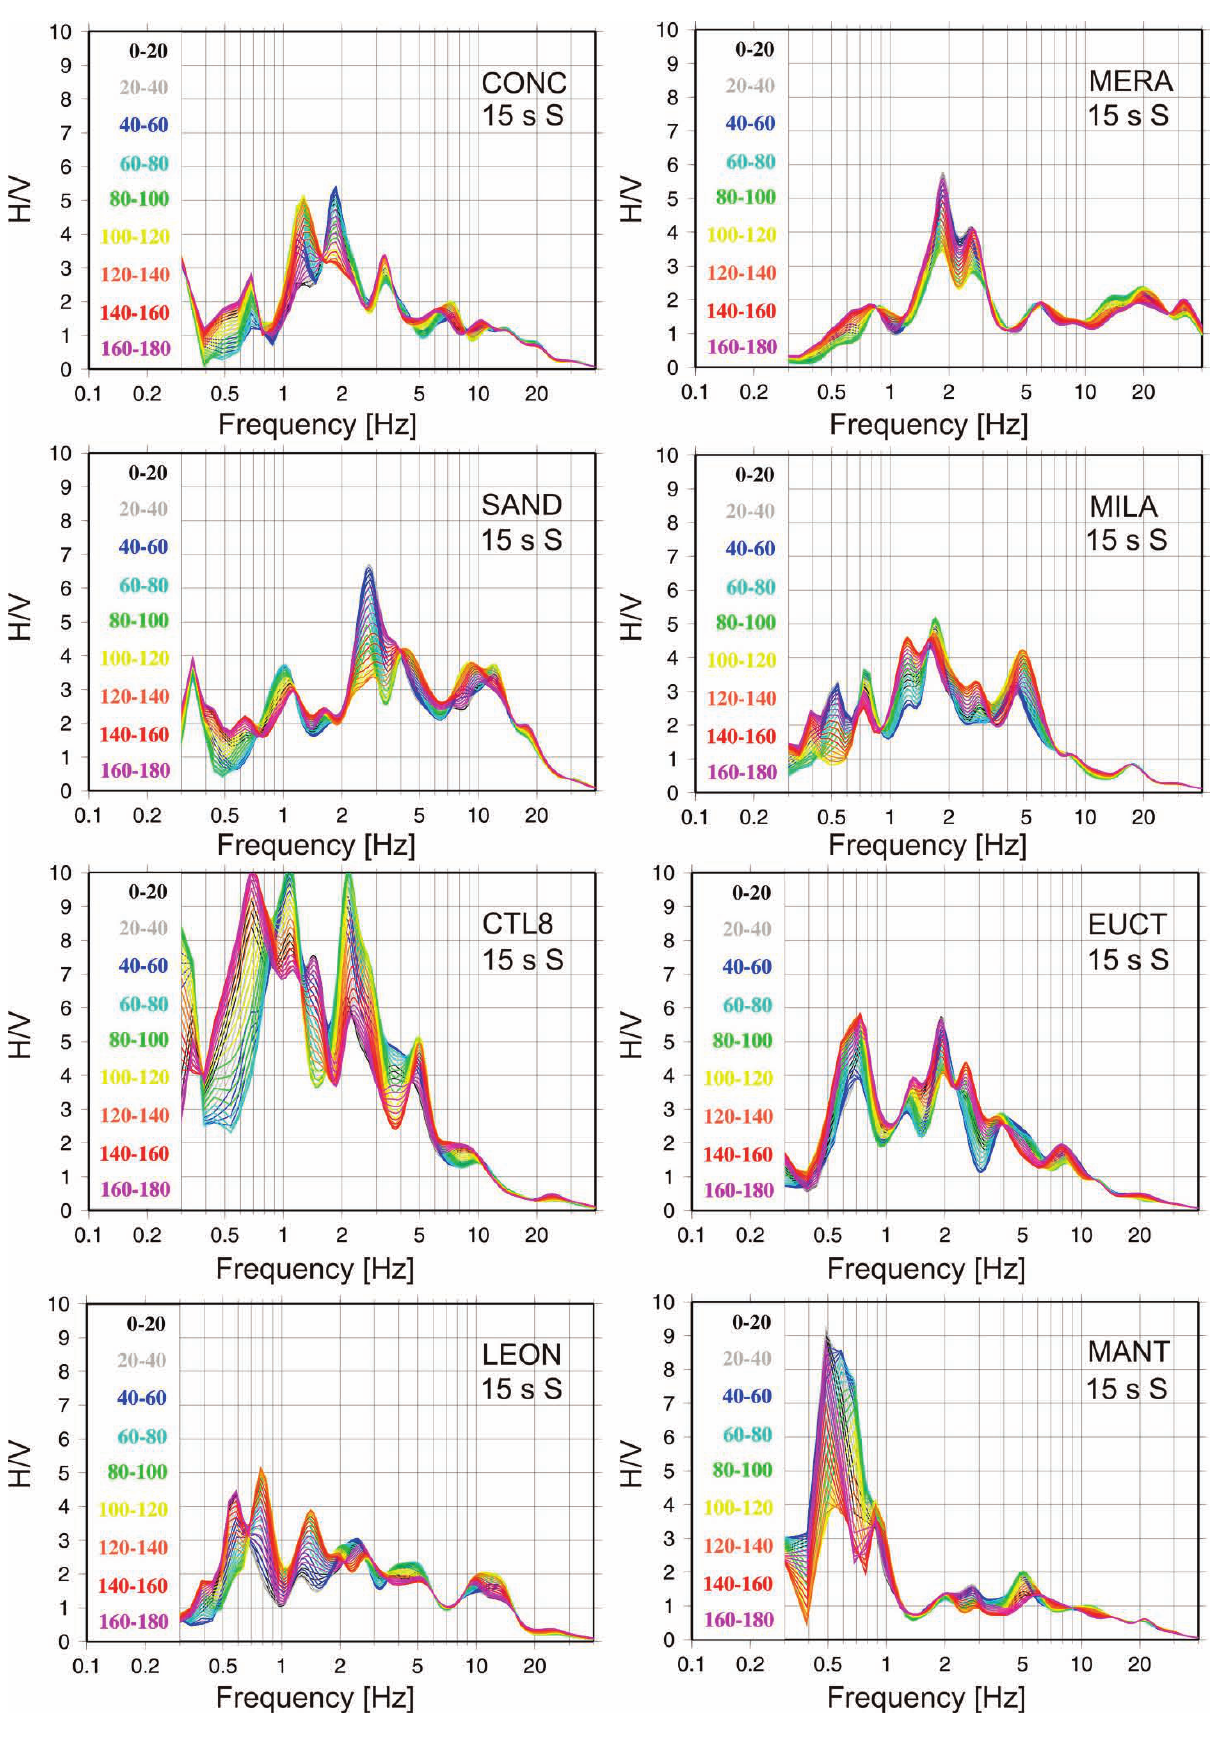
Figure 7. Directional (36 rotations, steps of 5˚, between 0˚ and 175˚) HVSRs for the stations considered, computed considering 15 s of S-phase. Different colors indicate consecutive directional HVSRs, grouped according to 20˚